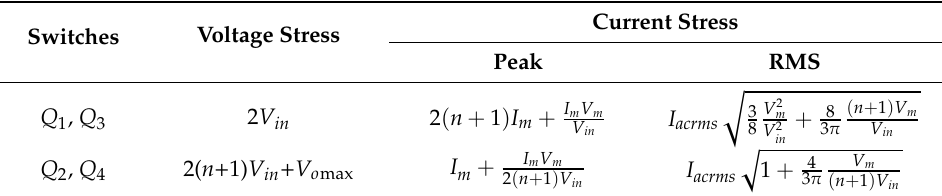
Table 4. SSBBI switch voltage and current